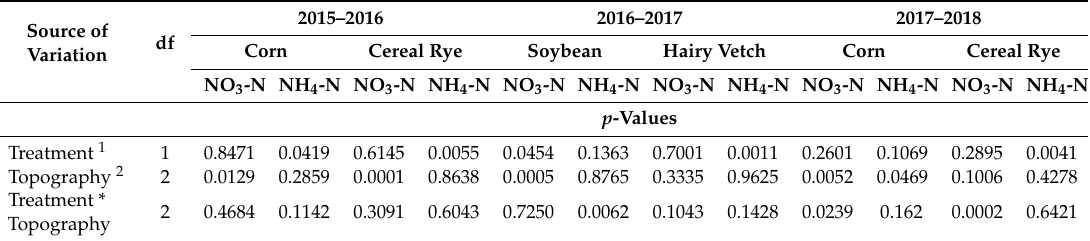
Table 3. Probability values ( p -values) and numerator degrees of freedom (df) associated with the sources of variation in the statistical analysis of nitrate-N (NO 3 -N) and ammonium-N (NH 4 -N) during the six soil sampling events for the crop-year.